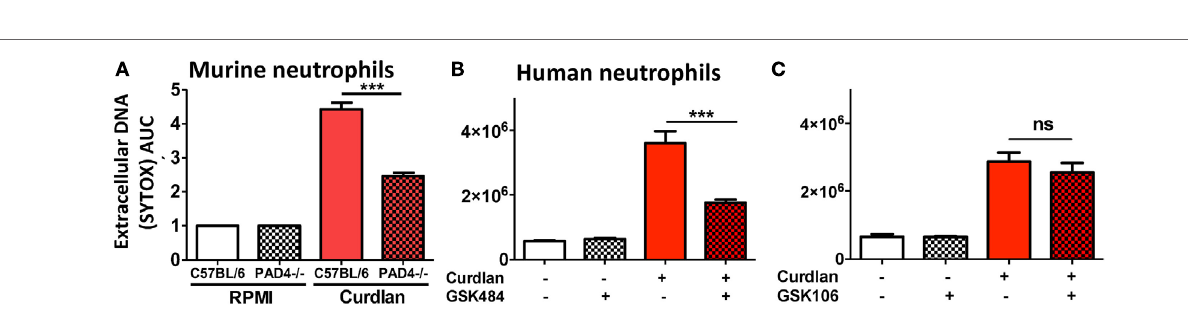
FigUre 4 | β -Glucan-induced neutrophil extracellular trap formation. Curdlan-stimulated bone marrow neutrophils from C57BL/6 and PAD4 − / − mice. Neutrophils were immunostained with antibodies to citrullinated histone 3 (H3Cit), neutrophil elastase (NE), and DAPI nuclear stain (a–c) 200 × ; (D–F) 400 ×